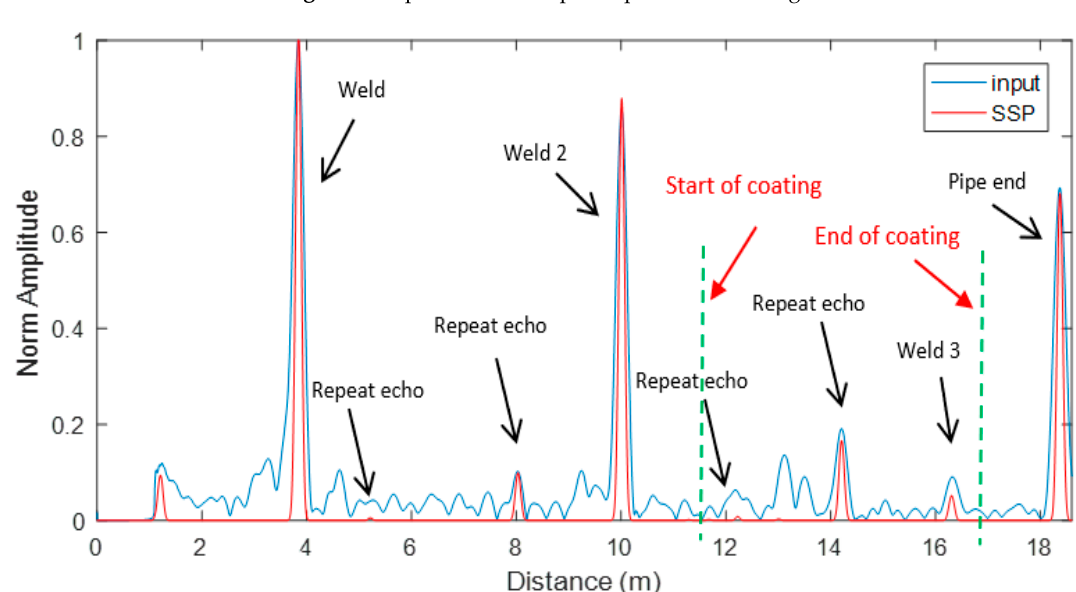
Figure 7. Unprocessed Teletest axisymmetric signal (blue trace) and SSP (red trace) signal with the optimum SSP filter bank parameters for 30 kHz.